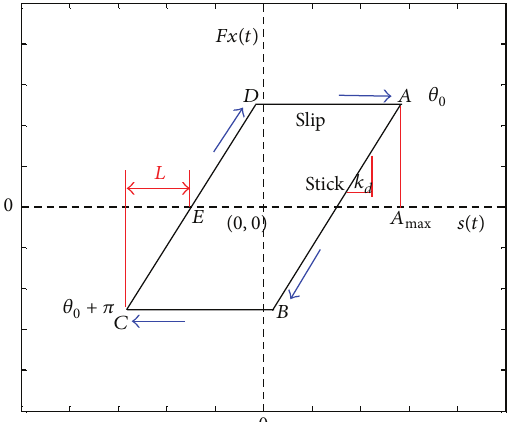
Figure 13: Phase diagram of the ideal stick-slip friction.